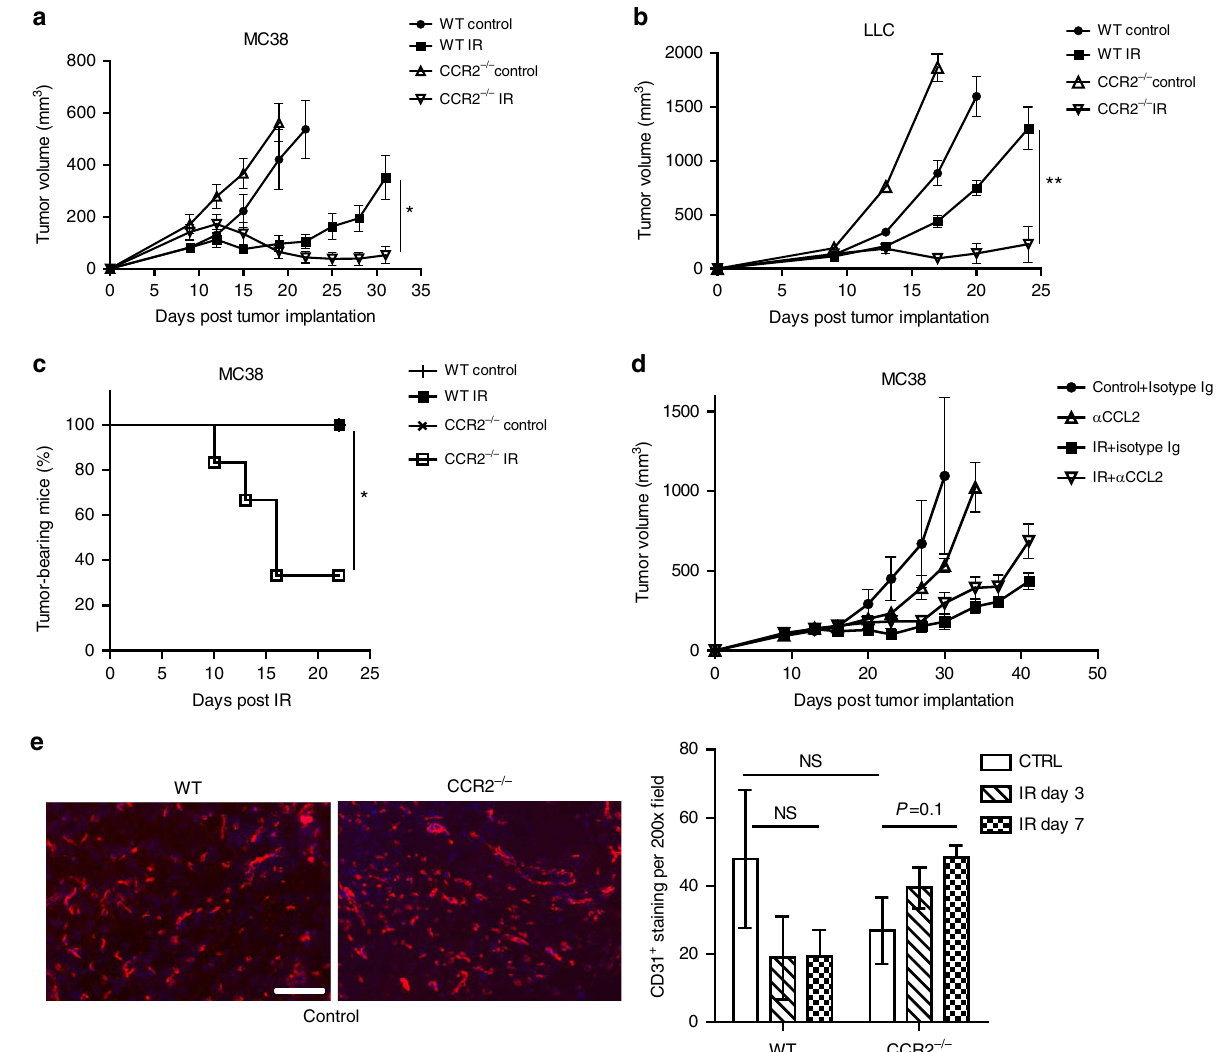
Fig. 2 CCR2 expression in the host is crucial for monocytic-MDSC mediated tumor resistance to radiation. CCR2 knockout sensitized tumor to radiation treatment. Tumors grown in CCR2 − / − mice were more radiosensitive than tumors in WT mice, in both the a MC38, and b LLC tumor models. c CCR2 de fi ciency in hosts led to eradication of 60% of tumors by IR. d Neutralization of CCL2 could not achieve better tumor control by IR. e CD31 staining (left) and quanti fi cation (right) of tumors grown in WT or CCR2 − / − mice. Tumors were harvested and frozen sections were fi xed and stained. CD31 positive cells in three DAPI positive fi elds from three mice were counted. Scale bar = 100 µ m; ** P < 0.01; * P < 0.05. Data are presented as mean